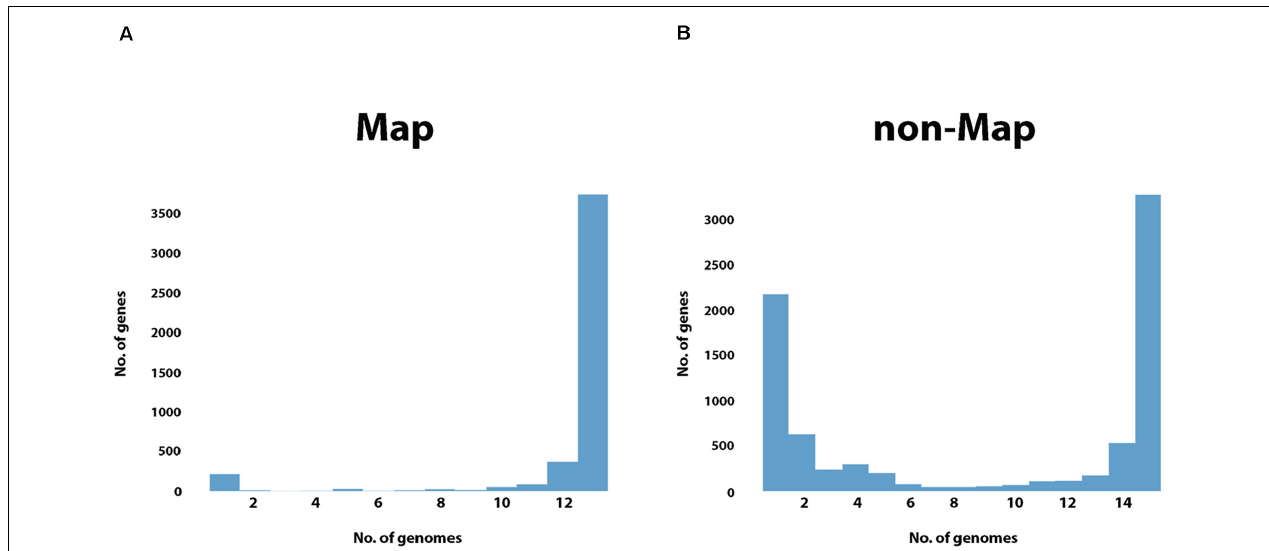
FIGURE 7 | Gene frequency within Map or non- Map genomes. Shown is a histogram plot with all the genes of the Map (A) or non- Map (B) pangenomes binned by their presence in 1 or more genomes ( x -axis). Note that most Map genes are present in 12 or all 13 genomes while the gene frequency in non- Map shows a biphasic distribution with many genes present in either a few (1–2) genomes or in most (14–15) genomes.